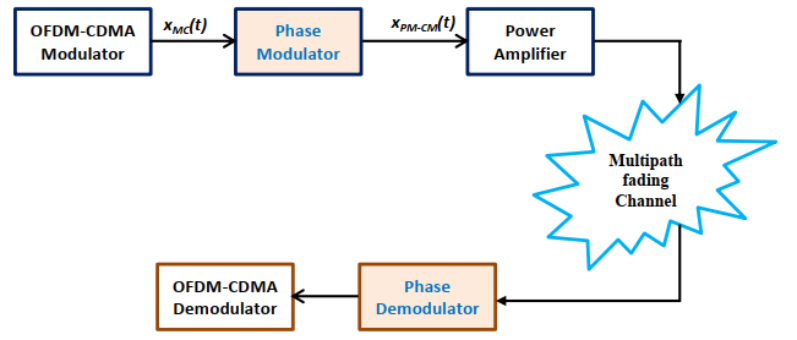
Figure 4. Base principle of the PM-OFDM-CDMA